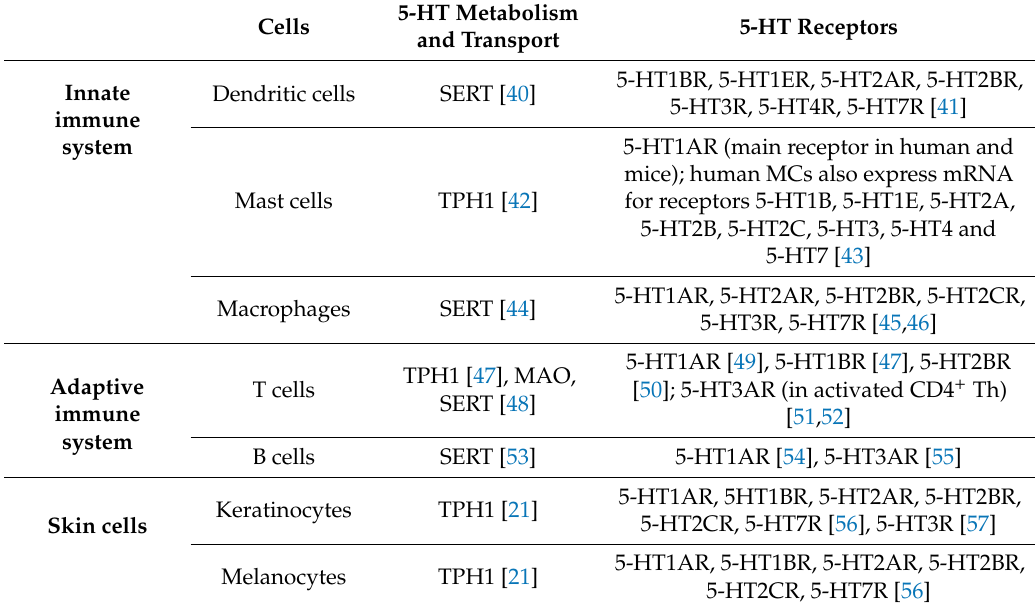
Table 1. The serotonergic system in human immune and skin cells. Note that some of these studies detected the gene expression (mRNA levels) which does not mean that the mRNA is translated into